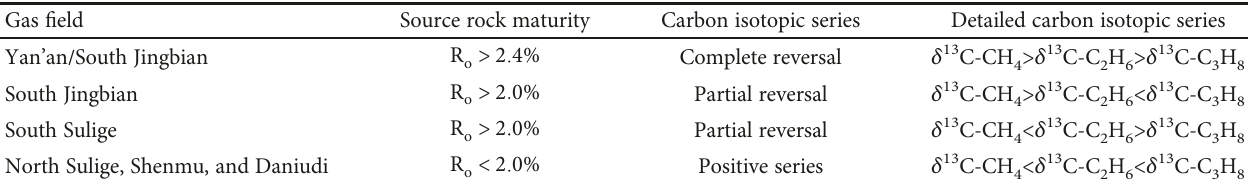
Figure 5: Carbon isotopic series of alkane gases in (a) Yan ’ an and upper Paleozoic South Jingbian gas fi elds; (b) lower Paleozoic South Jingbian fi eld; (c) southern Sulige fi eld; and (d) Daniudi, northern Sulige, and Shenmu gas fi elds. Table 2: Relationship between maturity and carbon isotopic series in the Ordos